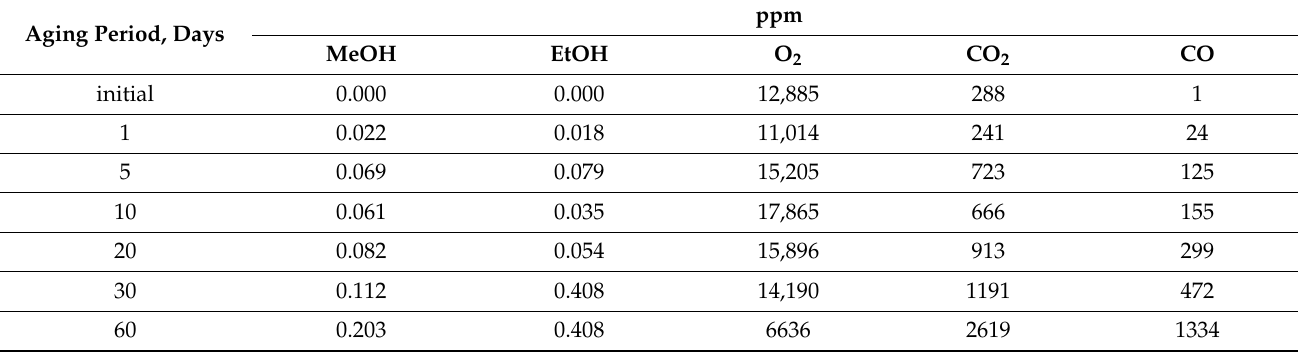
Table 6. Change of aging markers concentrations during Experiment I (oil only) at 120 ◦ C.